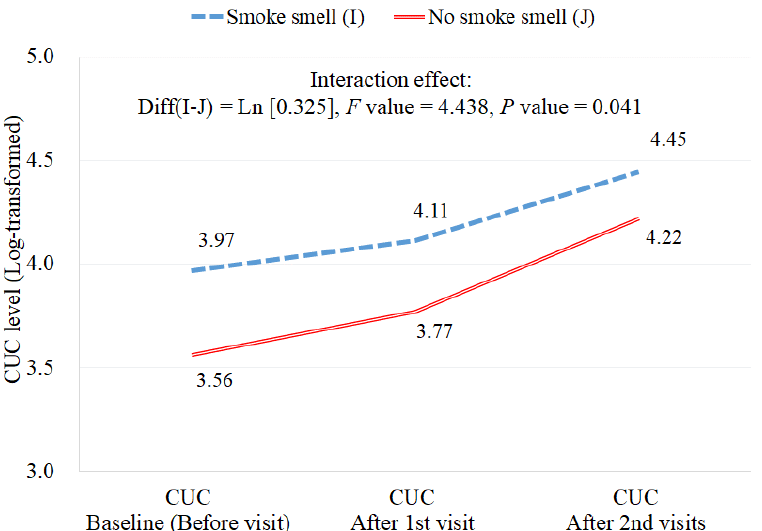
Figure 2. Interaction effect according to the presence or absence of cigarette smell in the facility. The analysis was performed for log-transformed concentrations. CUC: creatinine-corrected urine cotinine.